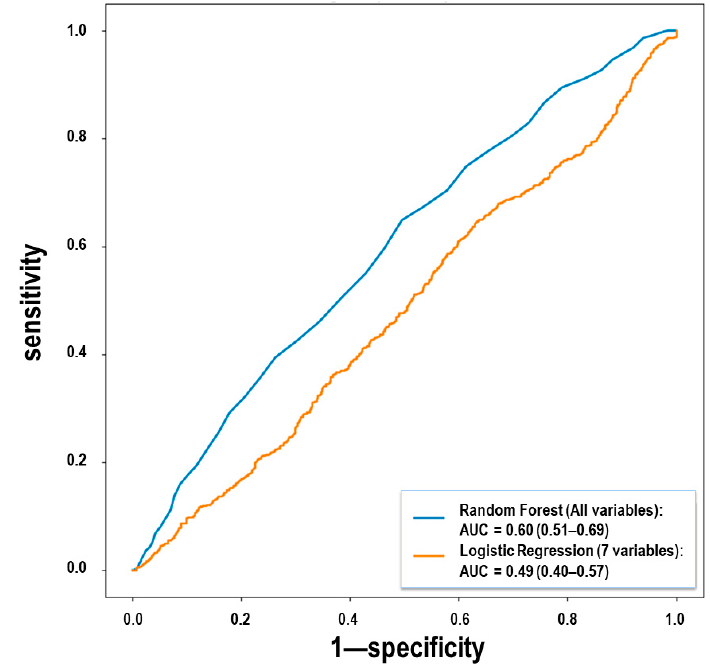
Figure 4. Receiver operating characteristic curves of the different classification algorithms for treat- ment difference, including best classifier (random forest with all variables) and logistic regression with 7 variables for comparison. The model with all variables was able to show statistically significant differences between both treatment groups but the model constructed with the 7 clinically relevant variables according to the COVID-19 Salamanca Risk Score did not find differences. Table 5. Relative importance of top 10 variables used by the random forest classifier according to mean decrease accuracy algorithm (scaled to the most important one).